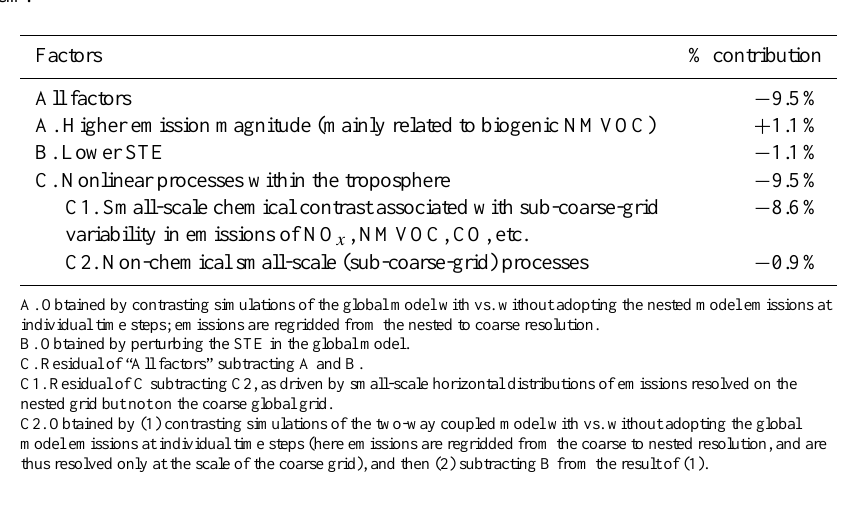
Table 5. Contributions of chemical and non-chemical factors to the change in 2009 tropospheric ozone from the global model alone to the two-way coupled